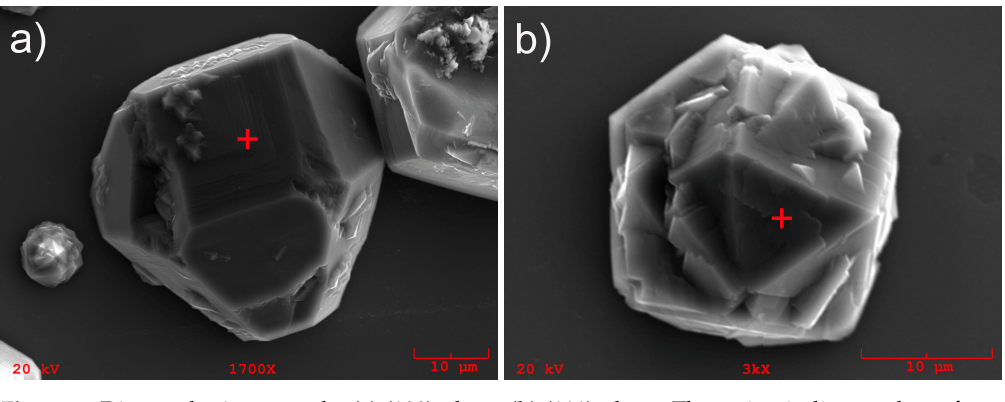
Figure 1. Diamond microcrystals: ( a ) (100) plane, ( b ) (111) plane. The + sign indicates places from which the cathodoluminescence CL spectrum were